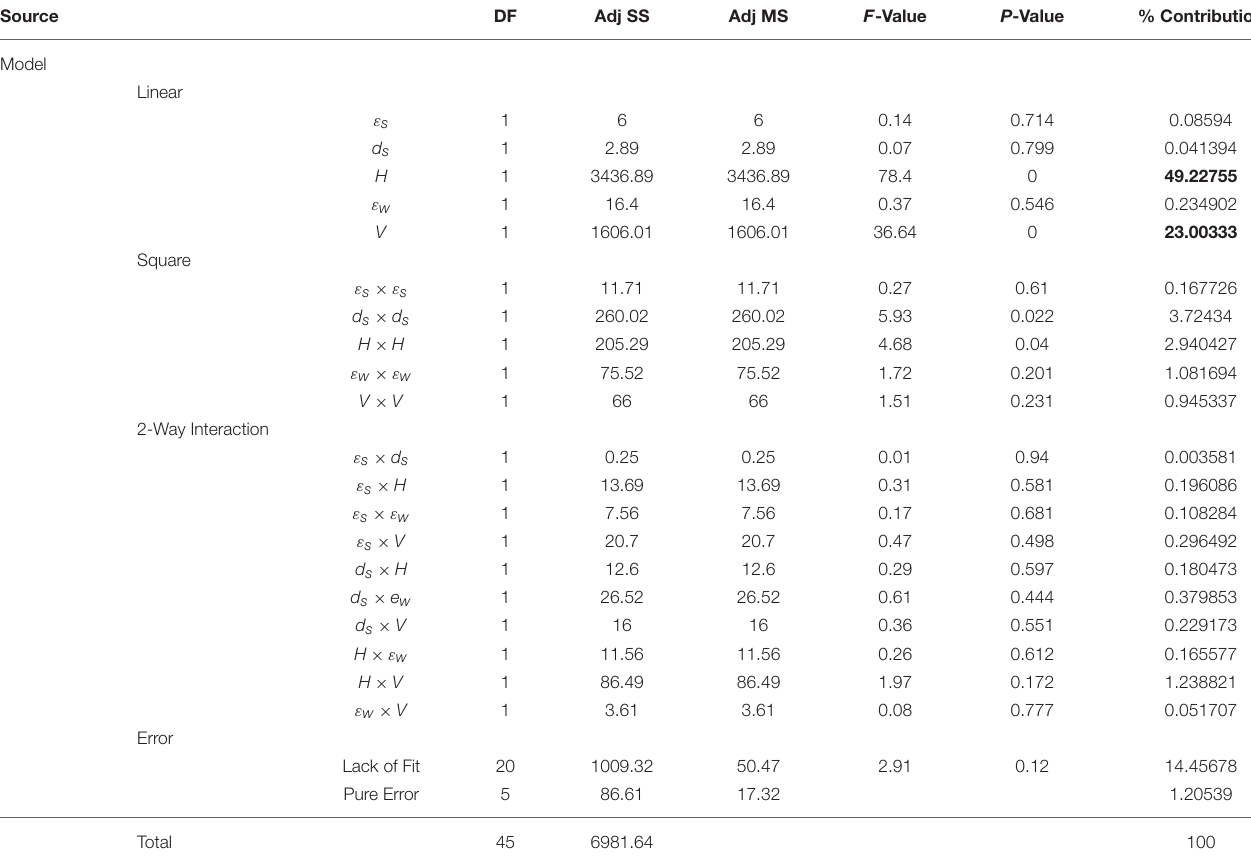
TABLE 3 | Results of the ANOVA for the steady-state value as the response variable. Source DF Adj SS Adj MS F -Value P -Value % Contribution Model